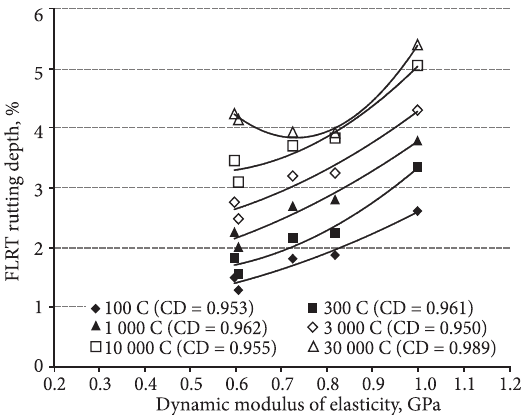
Fig. 2. Excellent relationships between dynamic modulus and FLRT rutting depth ( f = 1.0 Hz, T = +46.1 o C)